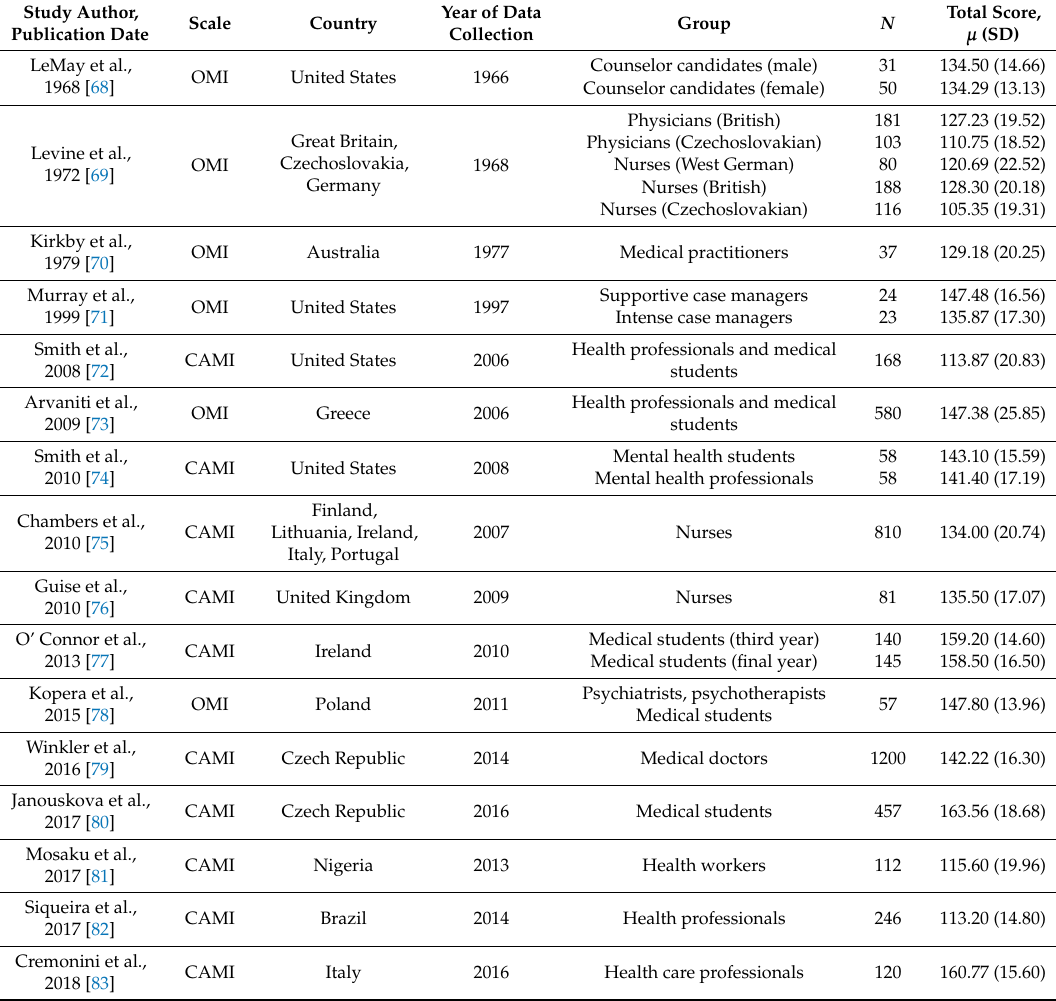
Table 2. Summary of characteristics of the 16 OMI / CAMI